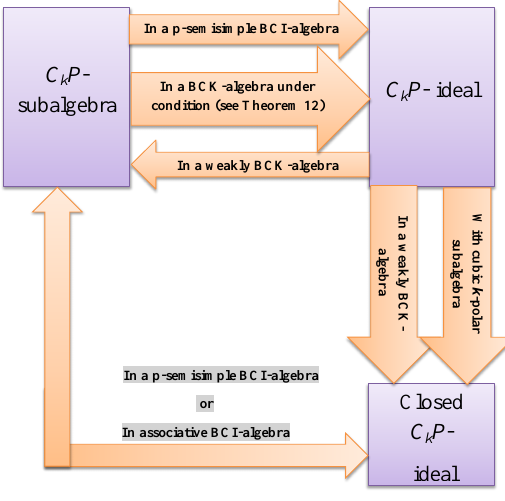
Figure 4. Algebraic relations part